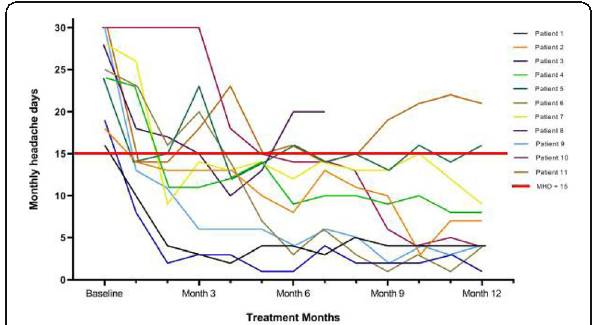
Fig. 1 (abstract P0298). See text for description